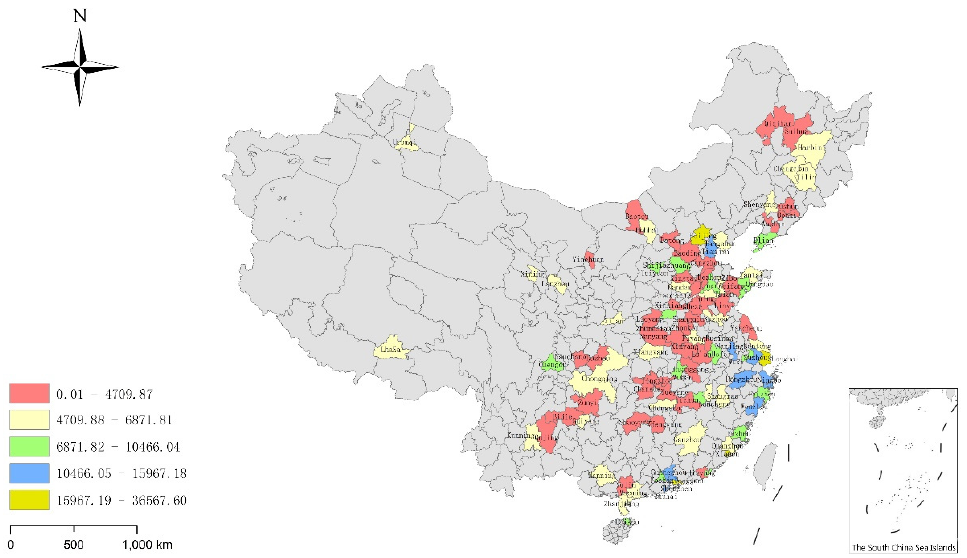
Figure 1. Housing price